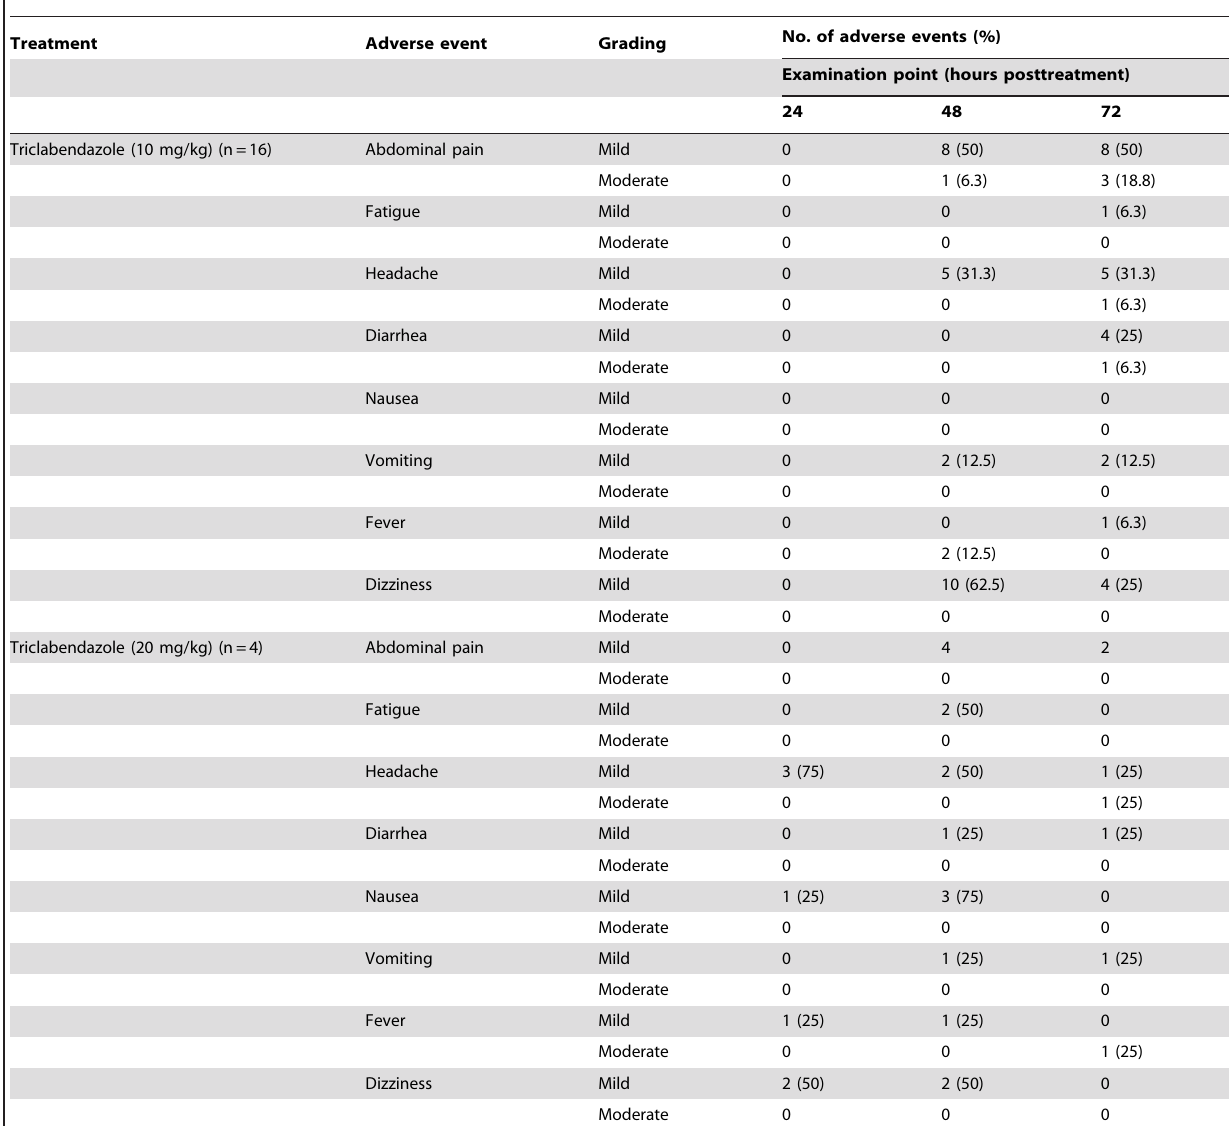
Table 6. Treatment-related adverse events observed in patients receiving triclabendazole.